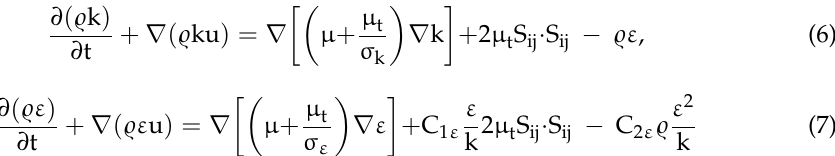
Figure 4. Schematic diagram of air age.